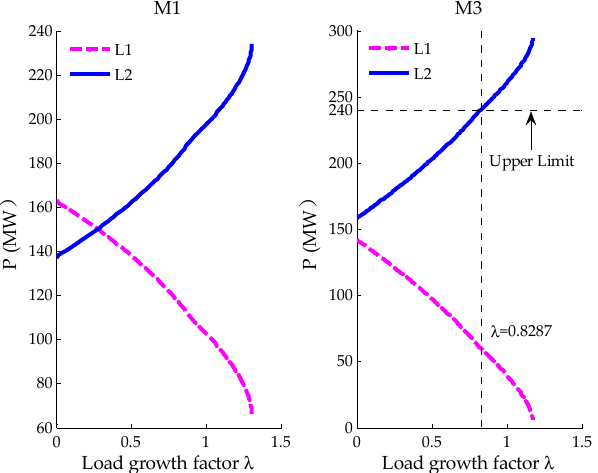
Figure 6. Curves of active power transmitted in tie-lines under schemes M1 and M3.